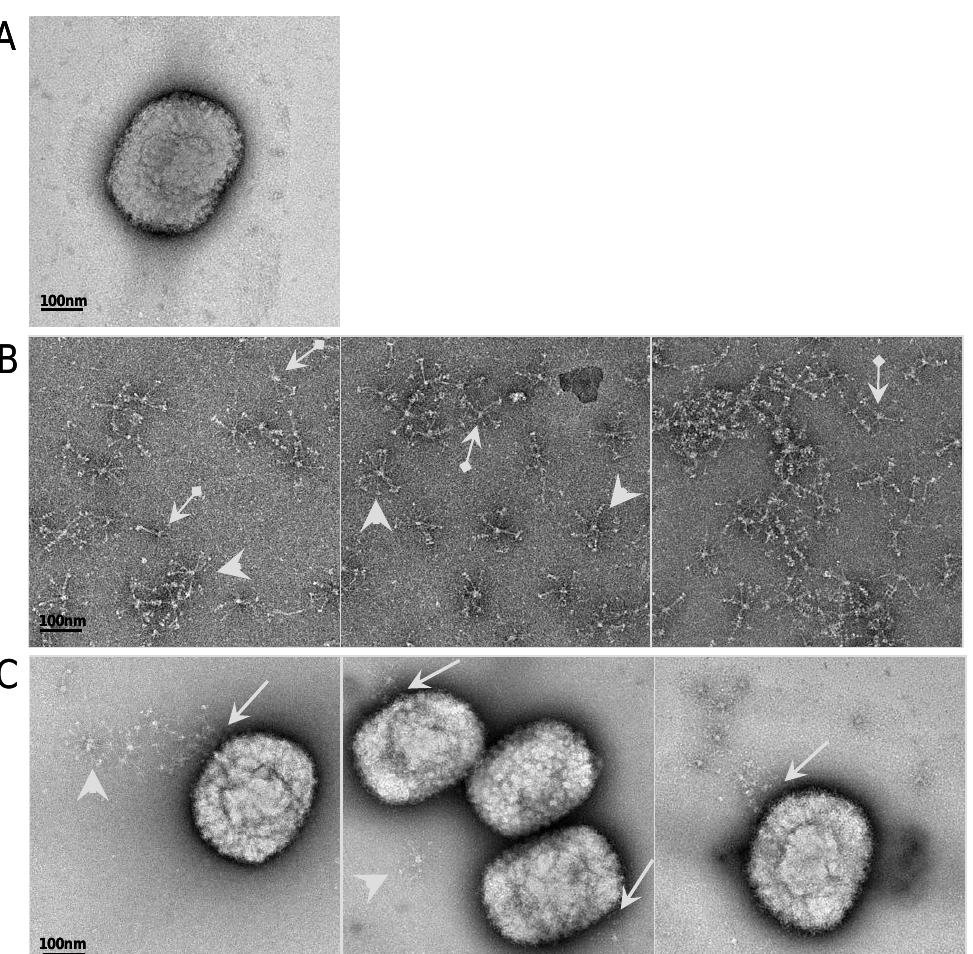
Figure 4. Electron Microscopy of virus particle interacting with SP-D. The interaction between inactivated VACV-WR and RhSP-D was illustrated. Panel A represents the inactivated virus. Panel B represents the control of RhSP-D (arrows: dodecamer, cruciform structure; and arrow heads: higher order multimers). Panel C displays the interaction and the site of attachment (arrows) between VACV-WR and RhSP-D; arrow heads represent isolated protein. The bar corresponds to 100